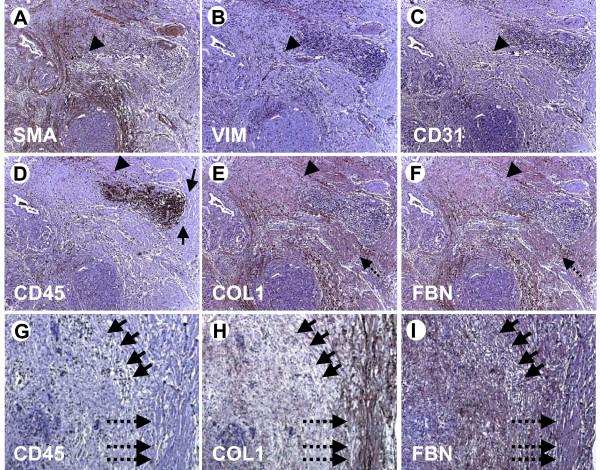
Immunohistochemistry of human chronic pancreatitis tissue specimens. Consecutive sections of chronic pancreatitis tissues were subjected to immunohistochemistry using antibodies against alphaSMA (A; SMA), vimentin (B; VIM), CD31 (C), CD45 (D), collagen1 (E; COL) and fibronectin (F; FBN). Arrows: area around packed clusters of mononuclear cells. Arrowheads in A-C: pancreatic stellate cells (SMA- and VIM-positive, CD31-negative). Arrowhead in D: loosely distributed area of mononuclear cell infiltration. Arrowhead in E&F: areas of less intense immunoreactivities for collagen1 and fibronectin. Dotted arrows: Areas of strong collagen1 and fibronectin staining. Original magnification: ×50. (G) Arrows: areas of loosely distributed/single mononuclear cells, dotted arrows: area without mononuclear cells. (H&I) Arrows/dotted arrows: corresponding areas to (G).